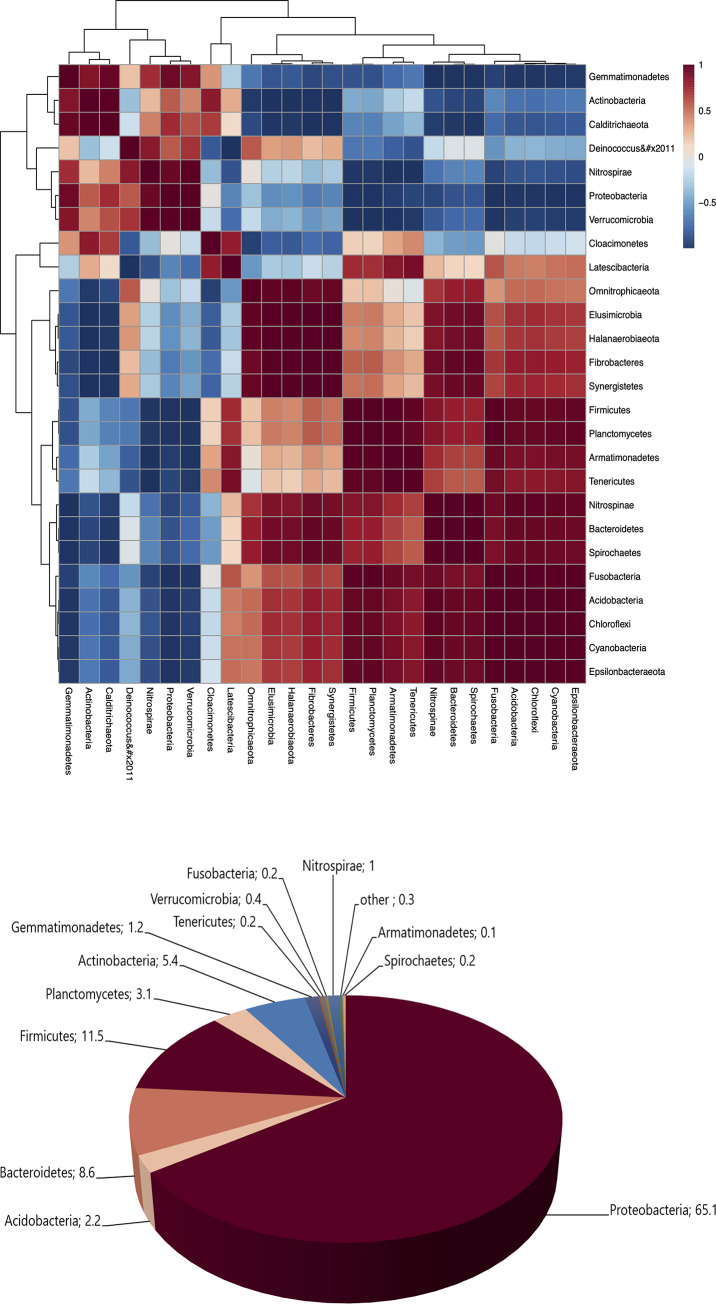
(a) Heatmap of Spearman's correlation coefficients between relative abundance of bacterial phyla in the biomixture. The colors of the boxes indicate the value of correlation coefficients. Darkest red indicates a perfect positive correlation (r = 1), darkest blue indicates perfect negative correlation (r = -1), and fading colors indicate a gradual loss in correlation. (b) Classification of bacterial community of biomixture in term of relative abundance.